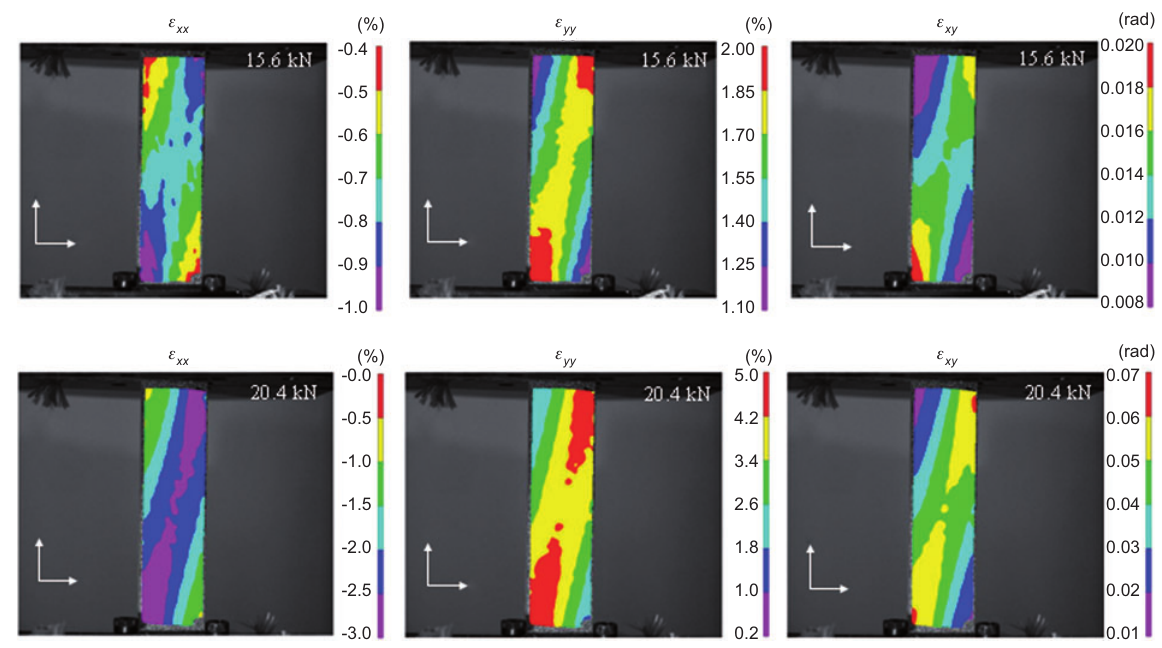
Figure 4 Strain component contours for 15 ° tension specimen.